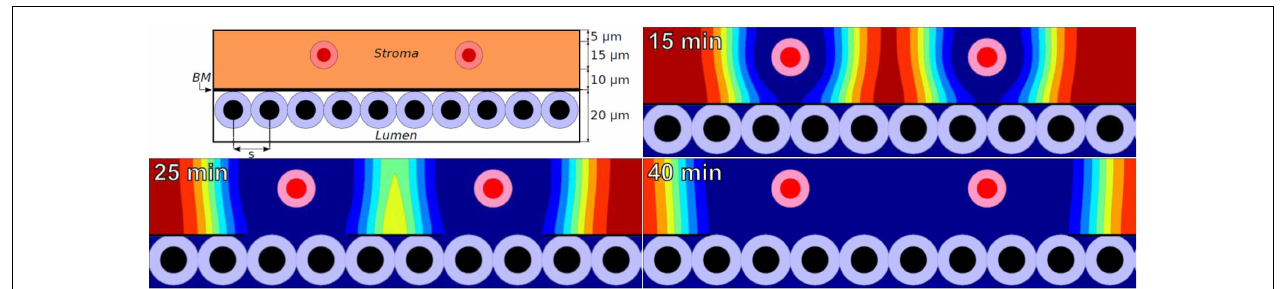
blue (0%) to red (85%)] at 15, 25, and 40min using a widespread ECM-MMP model with a biophysically reasonable reaction-diffusion length scale ( ∼ 10 µ m) and degradation rate ( ∼ 0.1–1min − 1